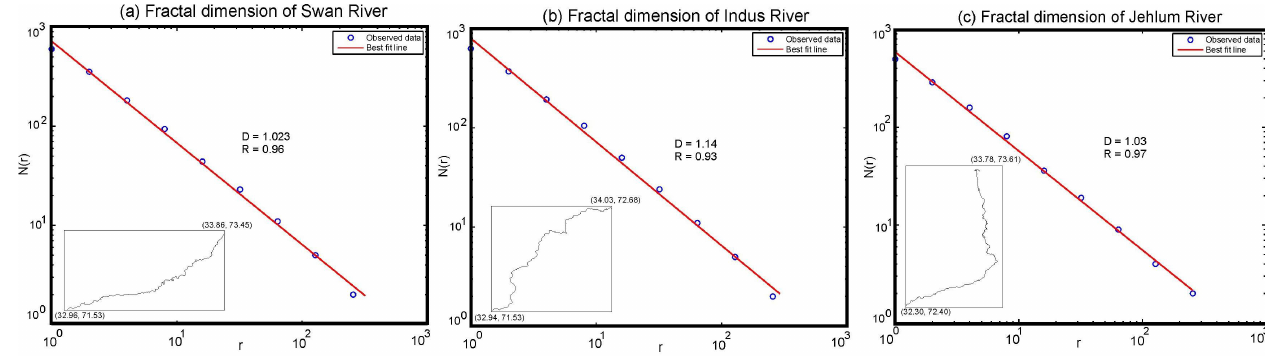
Fig. 3. Fractal dimension estimation of Swan, Indus and Jehlum Rivers with insets showing the orientation of the rivers.